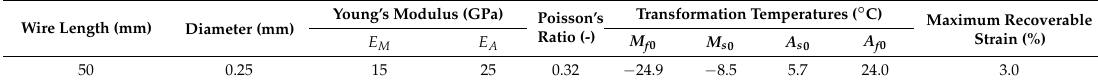
Table 2. Features of the SMA active